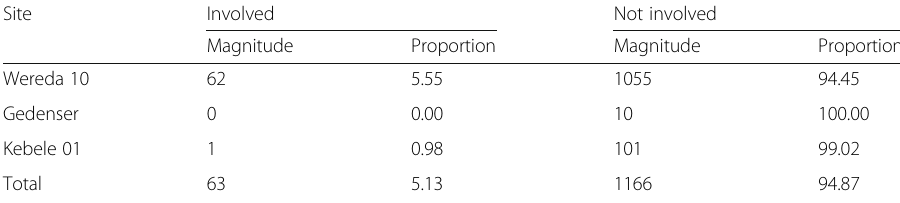
Table 6 Employed youth involvement in extra job (multiple employment) Site Involved Not involved Magnitude